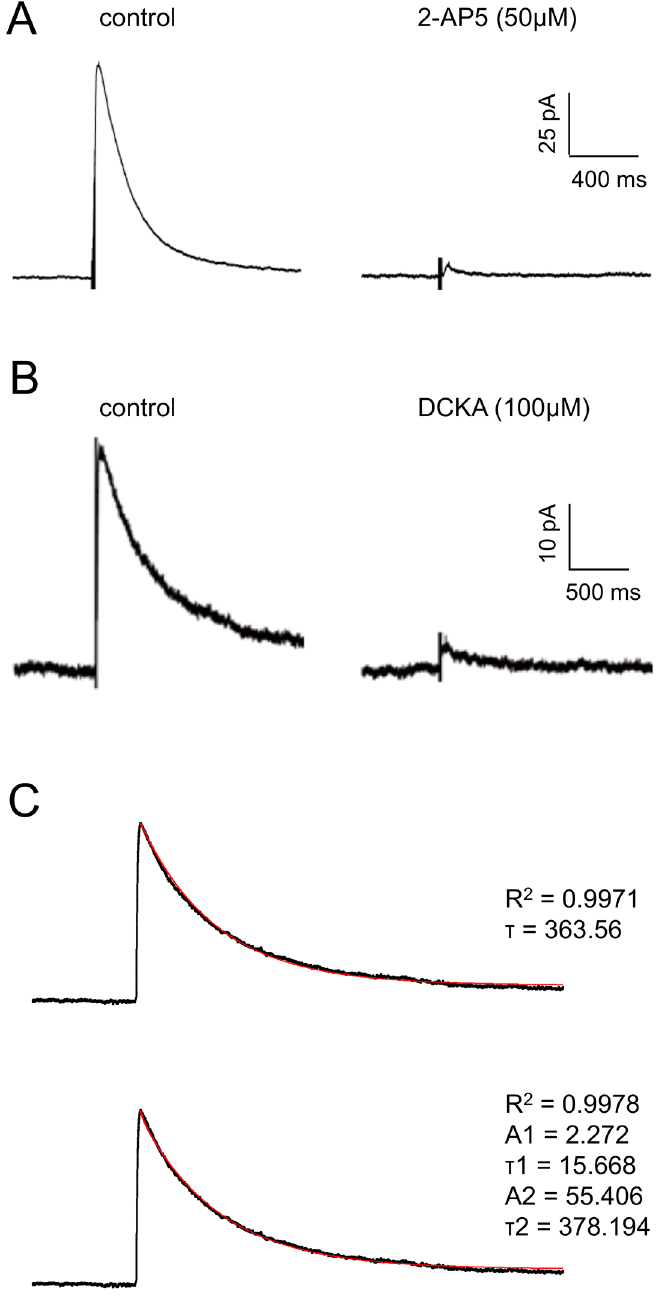
Fig 2. eNEPSCs in entorhinal neurones. The traces show voltage clamp recordings of eNEPSCs evoked in layer II neurones in the medial EC. Each response is the average of at least 5 events. A. The addition of the competitive antagonist, 2-AP5 abolished the eNEPSC. B. Likewise, application of the co-agonist site antagonist, DCKA, was also able to abolish the eNEPSC. C . The decay of n averaged (n = 8) eNEPSC was fitted with either a mono- (top) or bi-exponential function. Whilst R 2 values show an excellent fit to a biexponential decay, the mono-exponential fit was almost as good. The slow decay corresponding to tau-2 in the biexponential fit was extremely variable from neurone to neurone, and precluded meaningful analysis. Since the mono-exponential fit was excellent, in all further studies we assumed a mono-exponential decay.